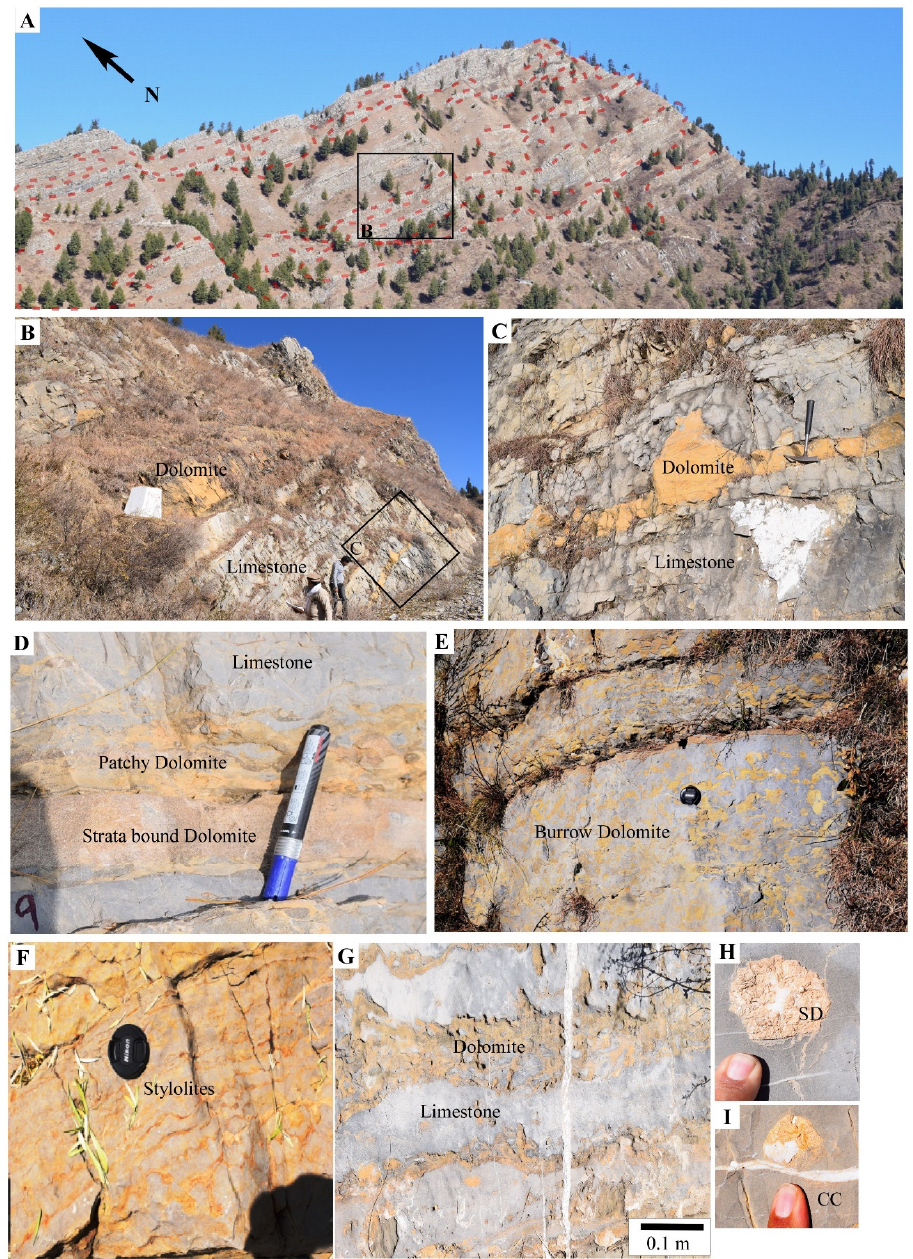
Figure 3. Outcrop photographs of the Samana Suk Formation show the different patterns of dolo- mitization. ( A ) A panoramic photograph of the outcrop of the Samana Suk Formation at Mera Rehmat Khan section, Hazara area. The dashed red line represents the dolomitization observed in the formation. ( B ) An inset image shows the dolomitization patterns observed. ( C ) Inset image of patchy brown dolomites after stratification. ( D ) Detailed view of strata-bound dolostone and patchy dolostone in contact with the host limestone. ( E ) Burrows are filled with brown dolomite as a result